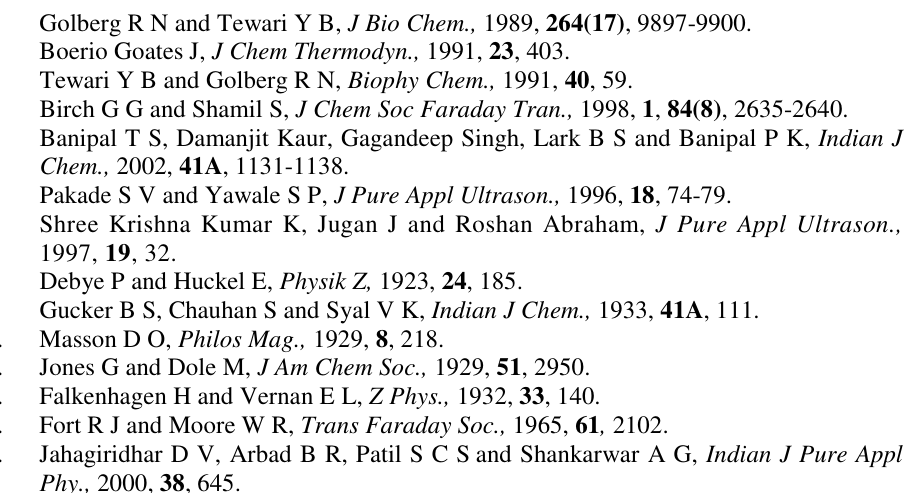
Table 3. Values of limiting apparent molal compressibility ( ϕ 0 volume ( ϕ 0 ), constants S and S and A and B - coefficients of Jones-Dole equation of V K V L -ascorbic acid, dextrose and sucrose in aqueous guanidine hydrochloride solution at 298.15 K Aqueous guanidine